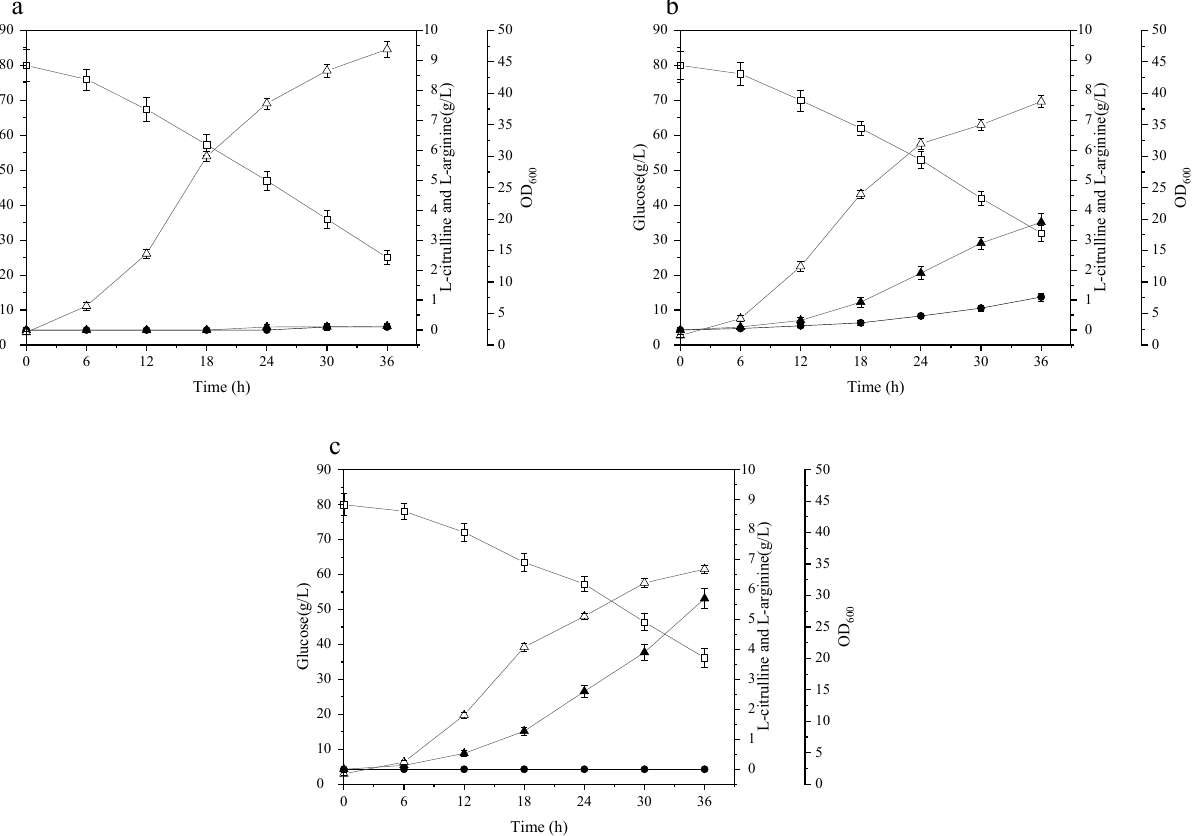
Figure 3. Batch fermentation of C. glutamicum ATCC13032 ( a ), CRB ( b ), and CRBG ( c ) strains in shake flasks. Signal denotes: filled triangle, L-citrulline; filled circle, L-arginine; empty square, glucose; and empty triangle, OD 600 . The error bars represent the standard deviation of three independent replicates.